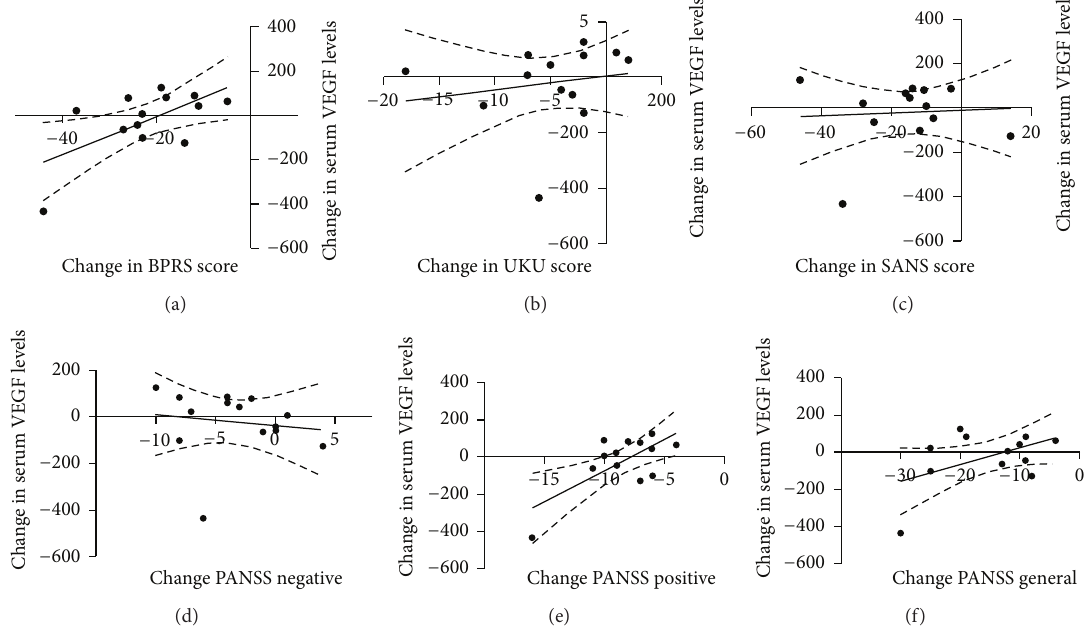
Figure 3: Relationship between changes in serum VEGF concentrations with changes in outcome measures. There were significant positive correlations between serum VEGF levels and improved scores on the BPRS (a) and PANNS positive (d). There were no significant correlations for changes in scores of UKU (b), SANS (c), PANSS negative (d), and PANSS general (f) with the difference in VEGF levels across both time